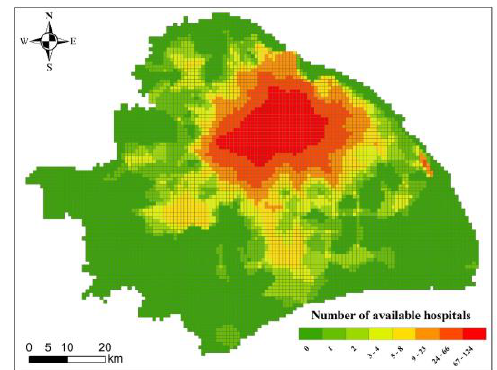
Figure 11. Spatial distribution of the number of available hospitals.